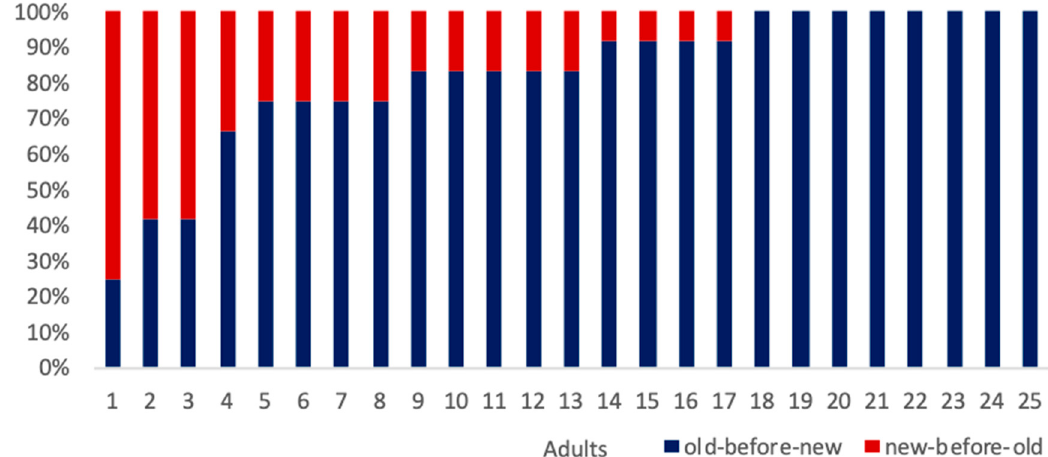
Figure 2. Mean proportions of “old-before-new” and “new-before-old” responses by adult.